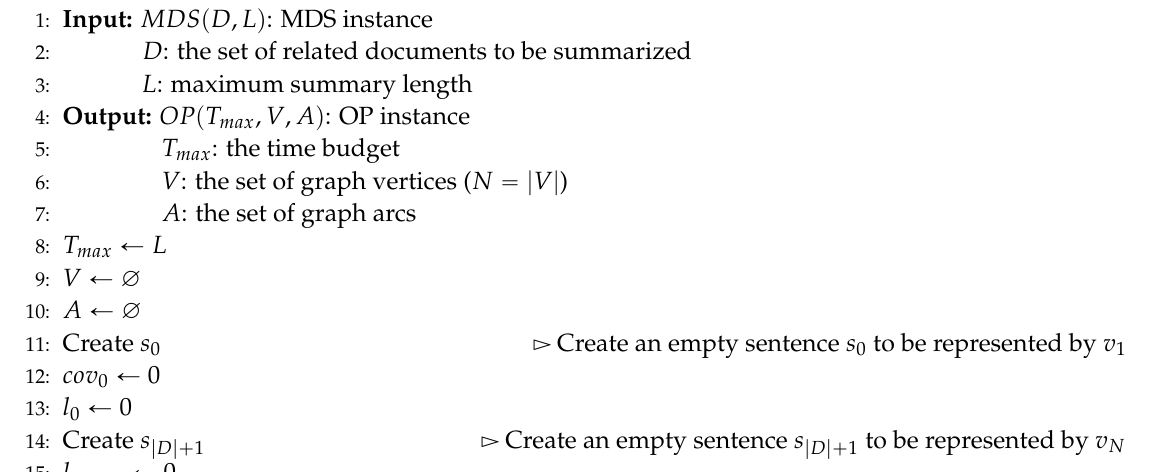
Algorithm 1 Encoding of an MDS instance into an OP instance.